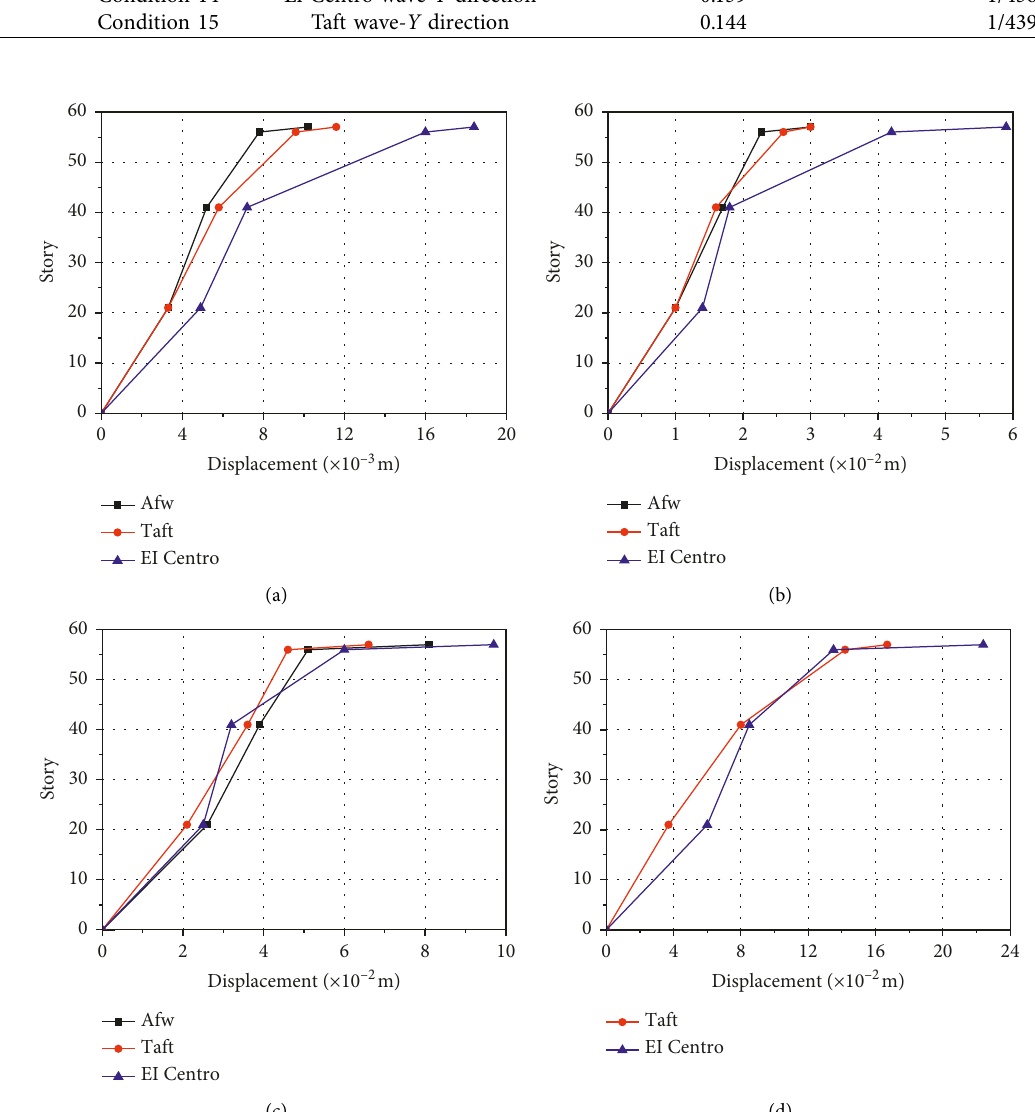
Figure 7: Envelope of relative displacement under different earthquake levels: (a) Frequent 6; (b) Moderate 6; (c) Rare 6; (d) Rare 7.